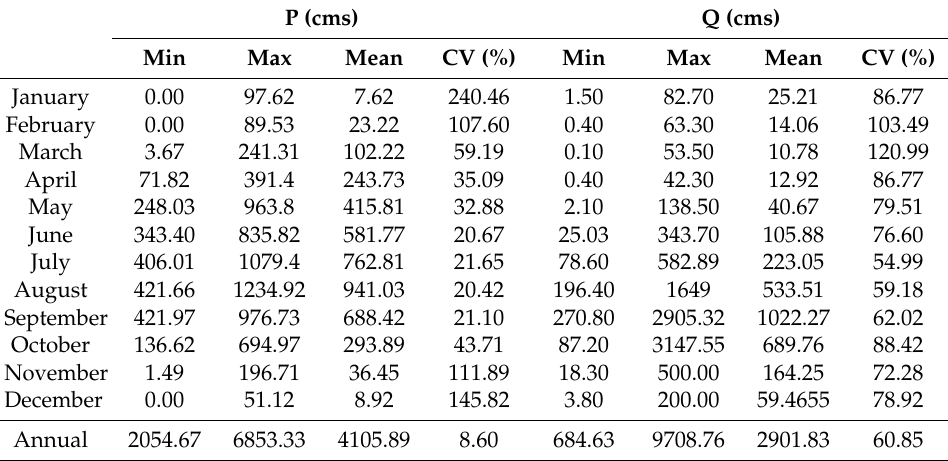
Table 3. Basic statistics on Rainfall Stream